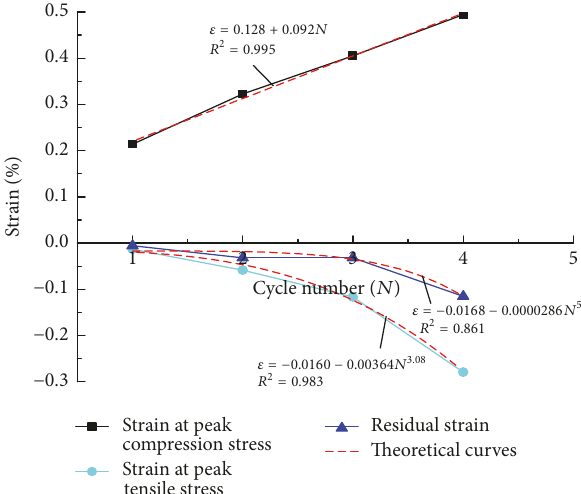
Figure 9: Curves of strains at peak stress point and residual strains versus cycle